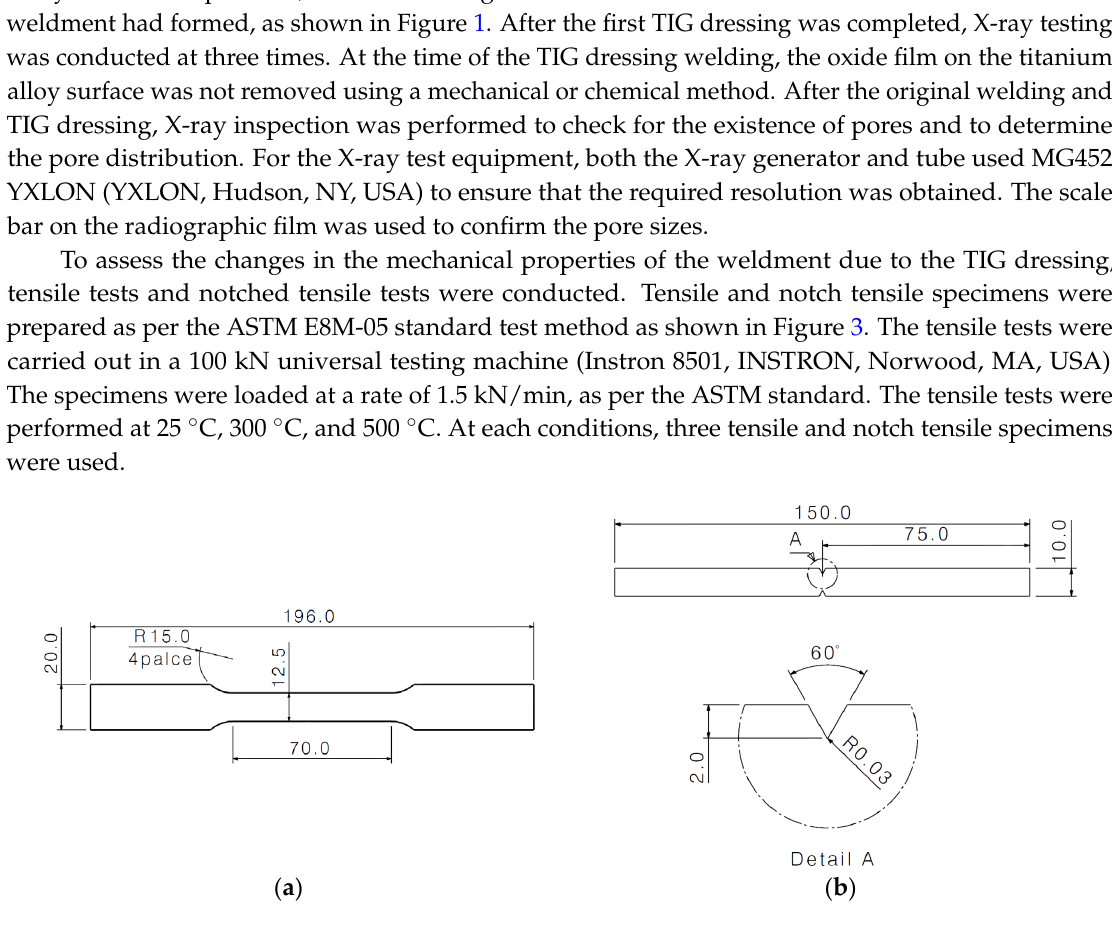
Figure 3. Illustration of tensile and notched tensile specimen: ( a ) tensile test; ( b ) notch tensile